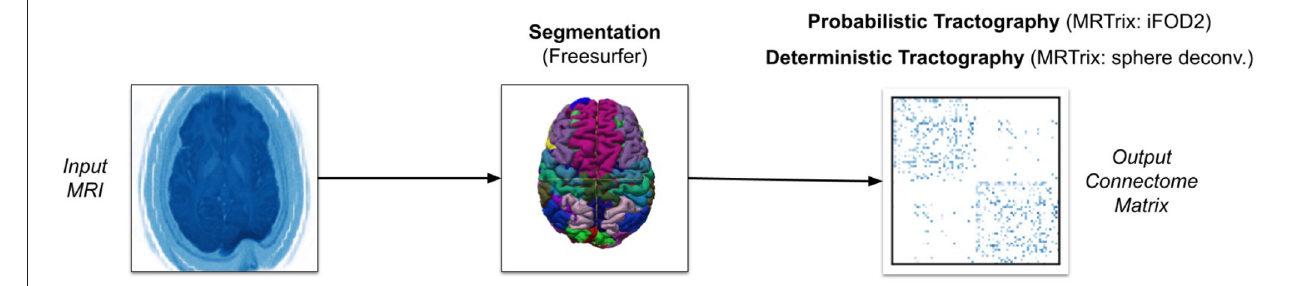
FIGURE 2 | Overview of alternative pipeline with MRTrix.